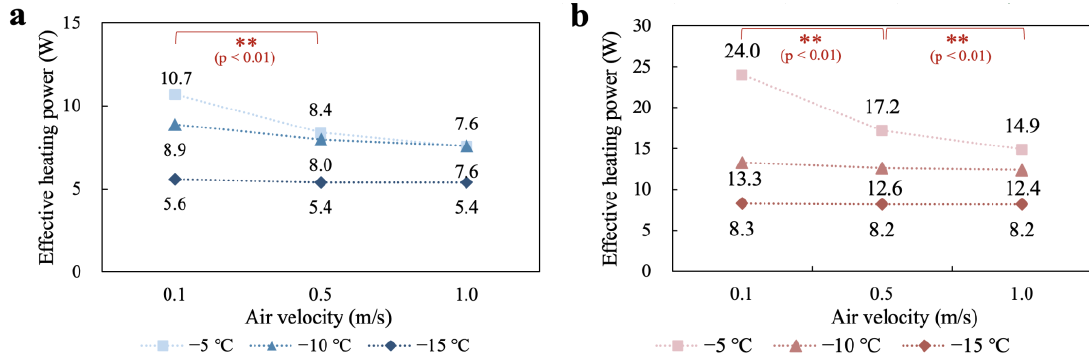
Figure 9. P eff of EHGs at different V a : ( a ) NAWH, ( b ) WAWH. Table 7. 𝜂 of EHGs at different V a .